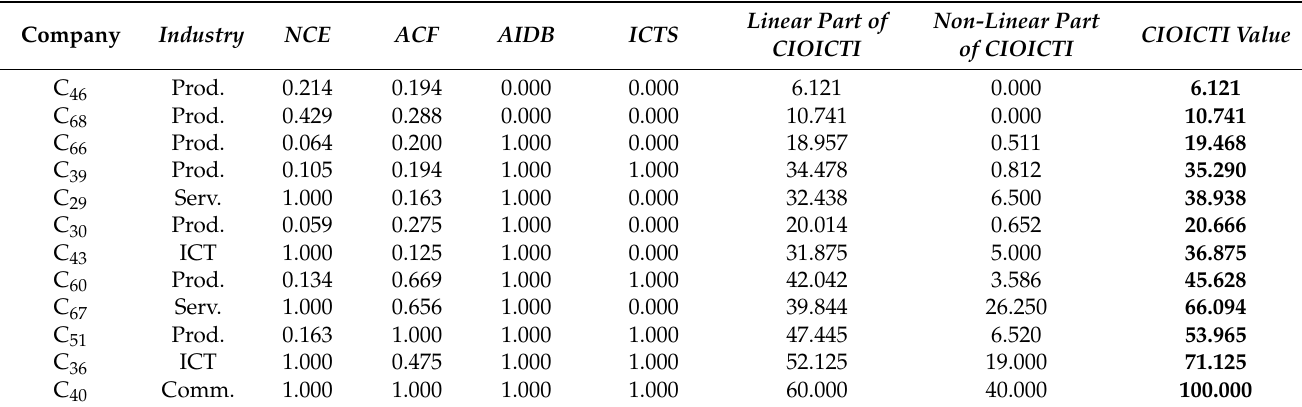
Table 7. Resulting values for the selected